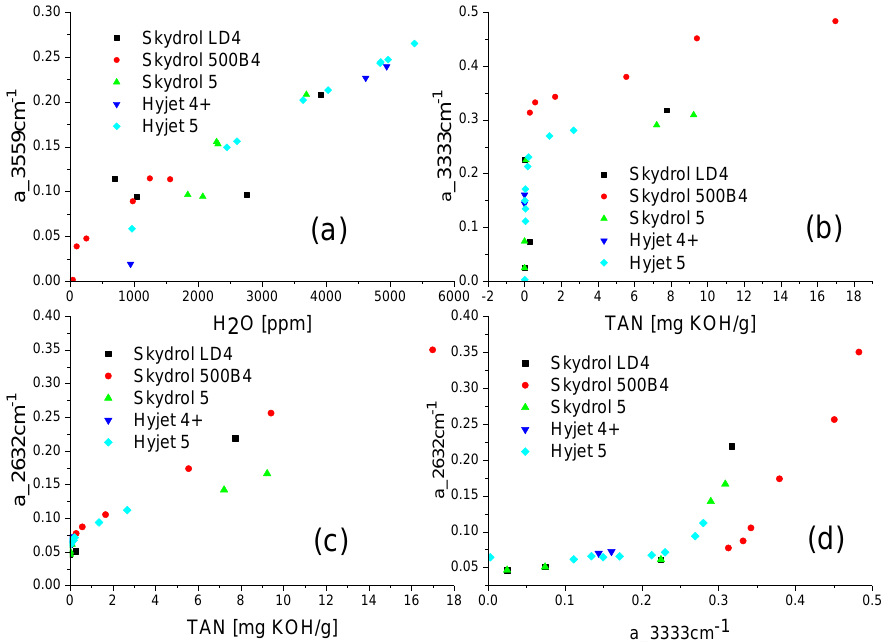
Figure 6. ( a ) Variation of normalized optical absorption in the 3559 cm − 1 water absorption window with the water content remaining in water-contaminated fluid samples after thermal degradation; Variation of the normalized optical absorption inside the 3333 cm − 1 alcohol ( b ) and 2632 cm − 1 phosphate absorption windows ( c ) with the TAN value in the same set of fluids; ( d ) Correlation of the phosphate and butanol / phenol absorptions in thermally degraded aviation fluids. Above a_3333 = 0.2 a rapid depletion of the acid scavengers is indicated